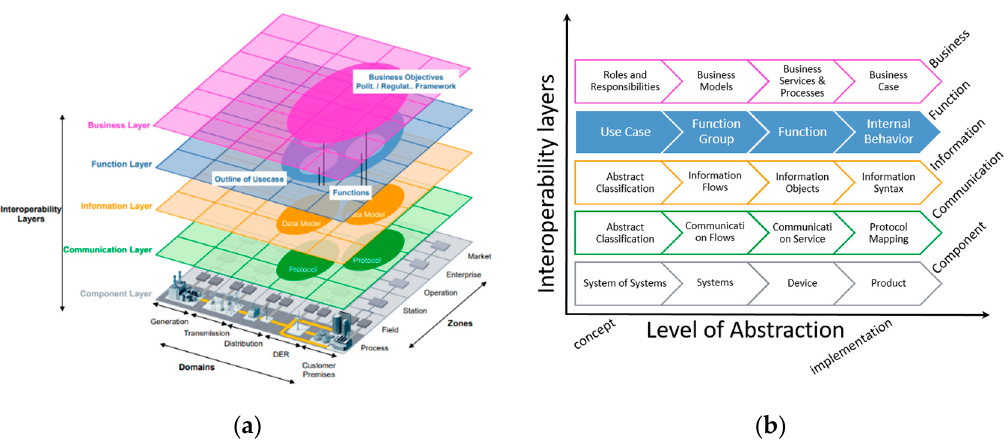
Figure 5. Smart grid architecture model (SGAM) and the levels of abstraction: ( a ) SGAM framework [45]; ( b ) exemplary categorization of di ff erent abstraction levels per SGAM layer. Adapted from